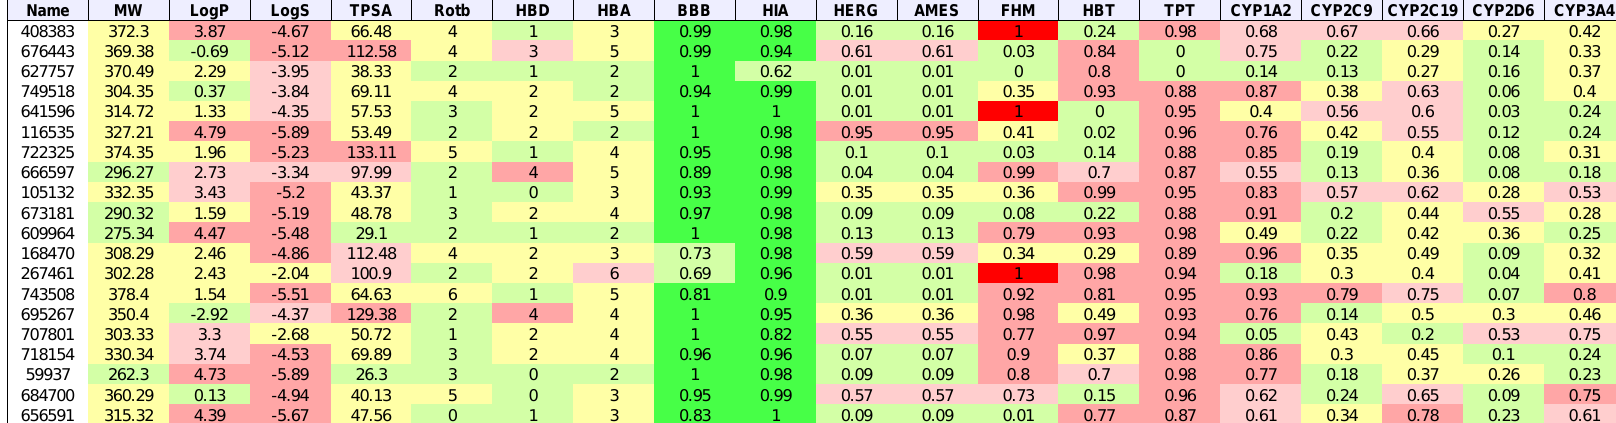
Table 3. AML: List of physio-chemical properties and predicted toxicology and ADME for top 20 ligands. Toxicology and ADME predictions are probabilities in the range [0, 1] *.